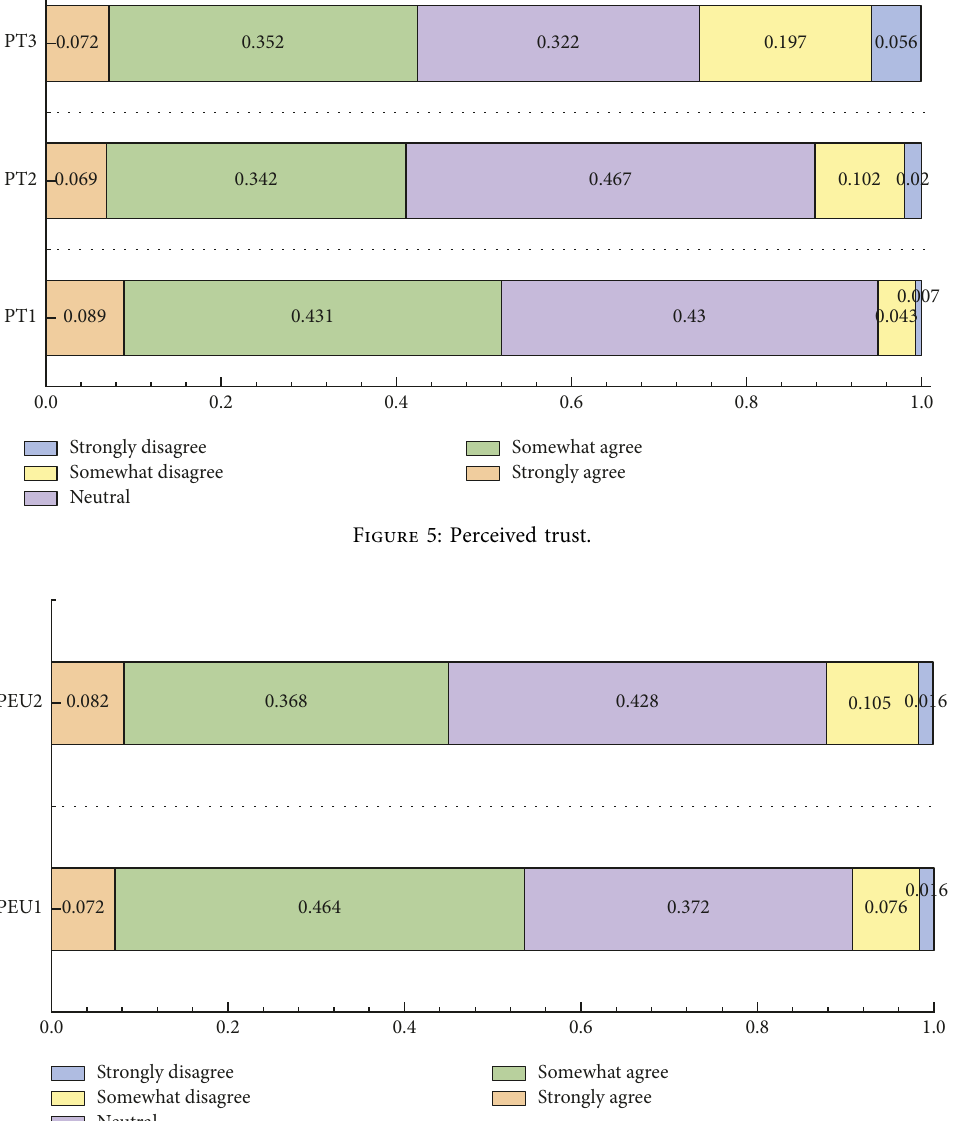
Figure 5: Perceived trust.